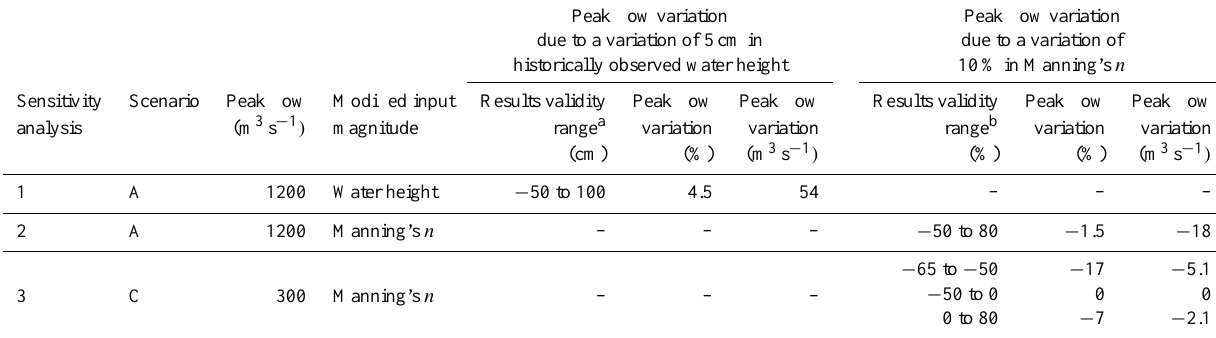
Table 4. Results of the sensitivity analyses performed by varying historically observed maximum water height and Manning’s n